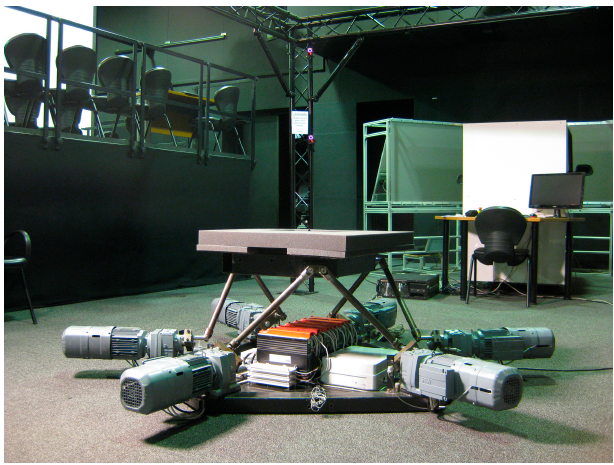
Figure 8. Example of a Stewart-like 6-DOF motion platform.